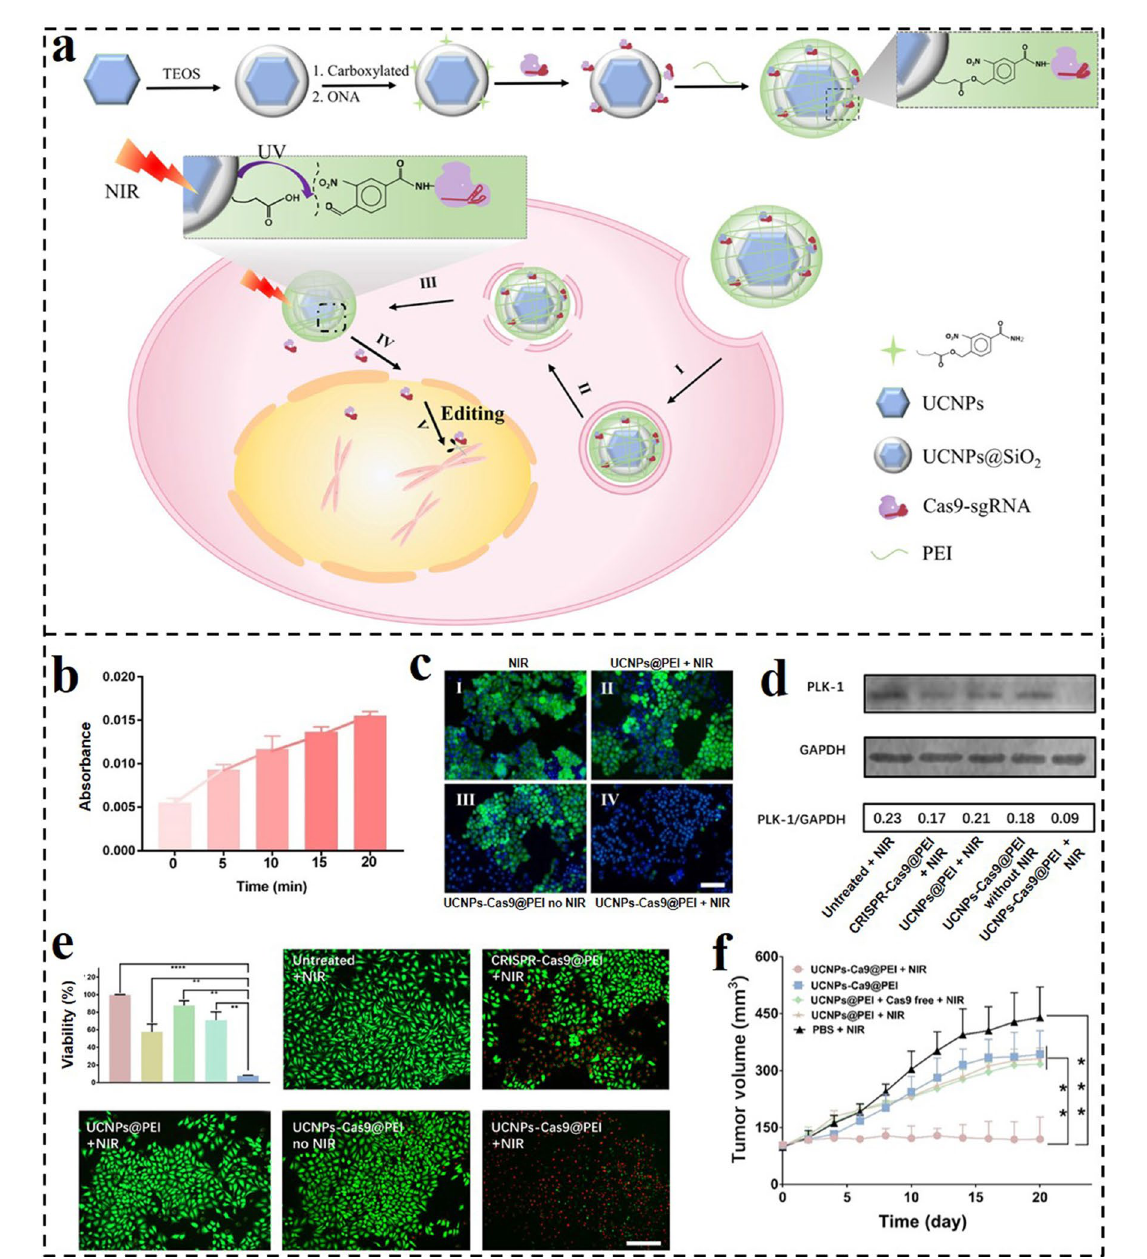
Fig. 13 a Preparation of UCNPs-Cas9@PEI and the NIR-triggered delivery of Cas9-sgRNA to the nucleus of the cell for gene editing. b UV– Vis absorption of the supernatant of UCNPs-Cas9 with different irradiation times by a 980 nm laser. c Fluorescence microscopy images of EGFP in KB cells treated with different formulations. d Western blot assay of PLK1 protein after A549 cells treated with different formulations. e CCK-8 and live/dead staining analyses of A549 cells treated with different formulations. f Tumor sizes after different treatments [176]. Copy- right 2019, American Association for the Advancement of